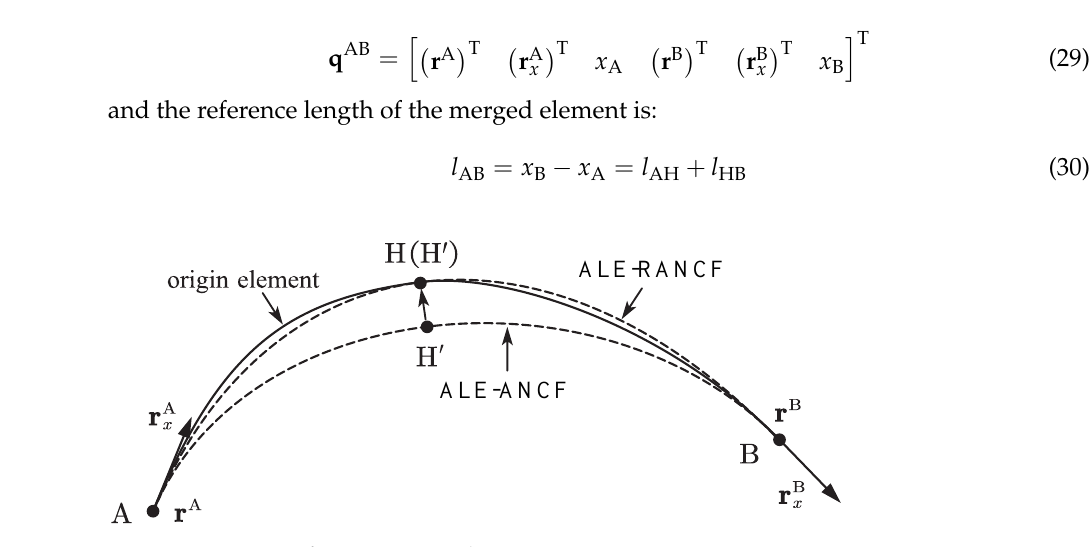
Figure 5. Merging of ALE-RANCF